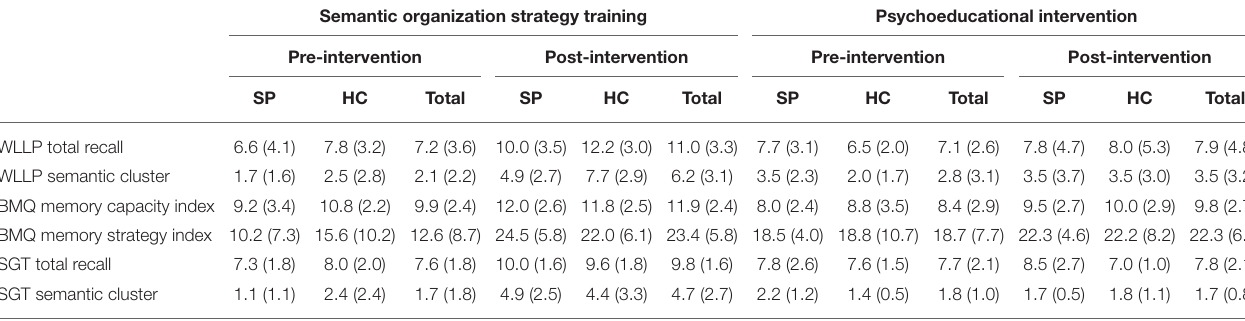
TABLE 1 | Demographic and behavioral results for stroke patients (SP) and healthy controls (HC). Semantic organization strategy training Psychoeducational intervention Pre-intervention Post-intervention Pre-intervention Post-intervention